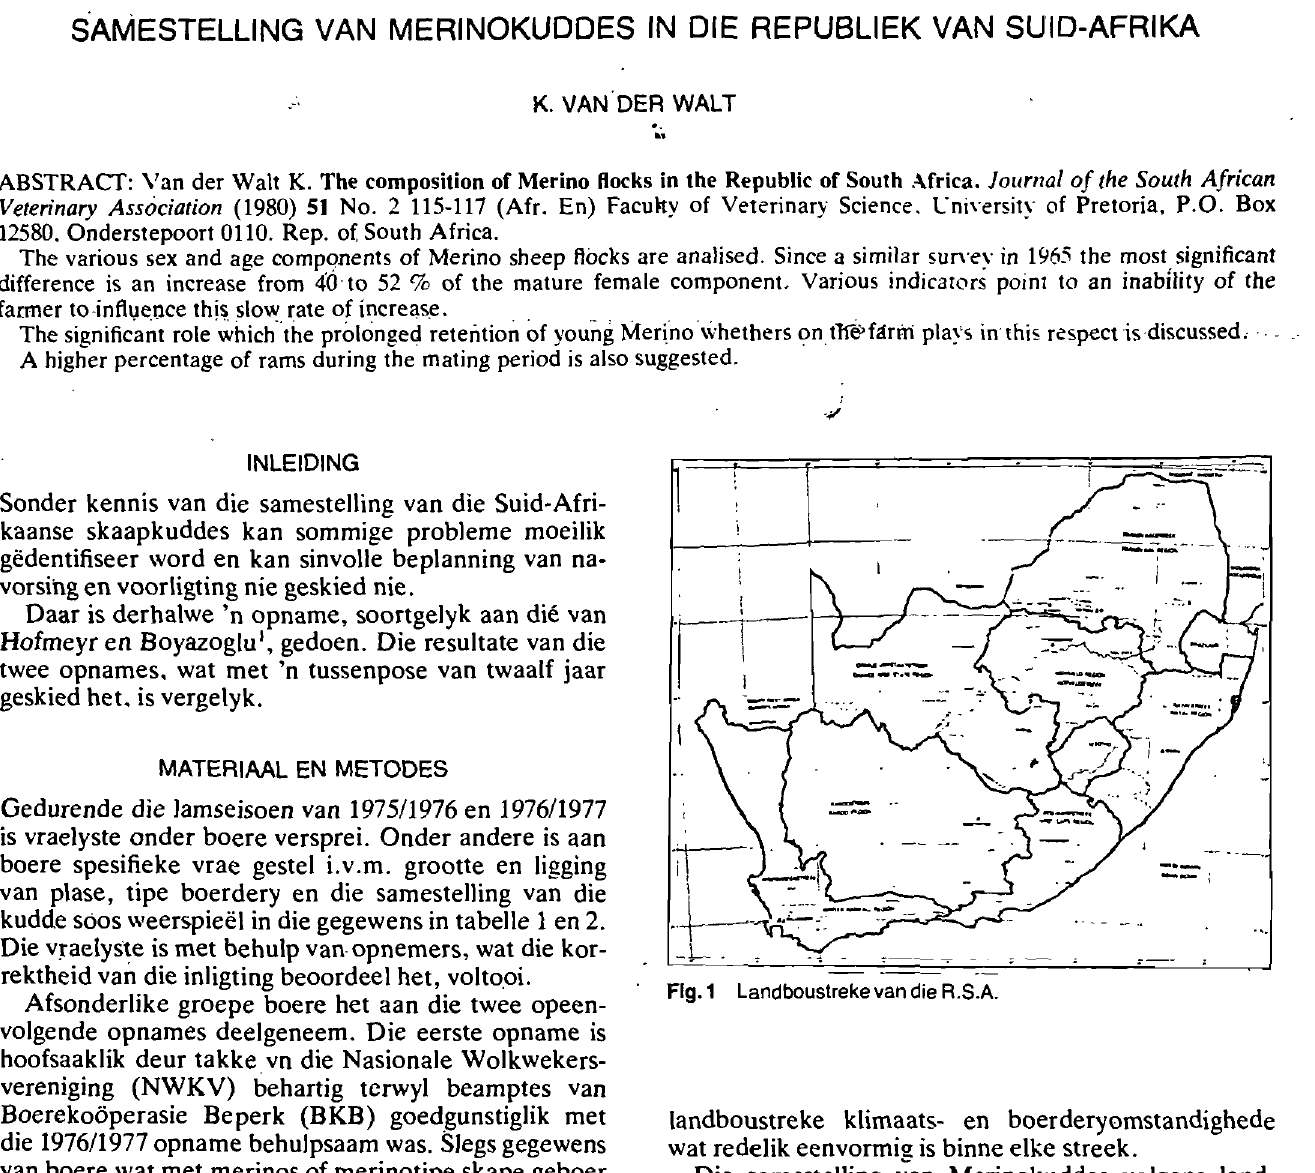
Table 1: GEMIDDELDE SAMESTELUNG VAN MERINOKUDDES VOLGENS LANDBOUSTREKE